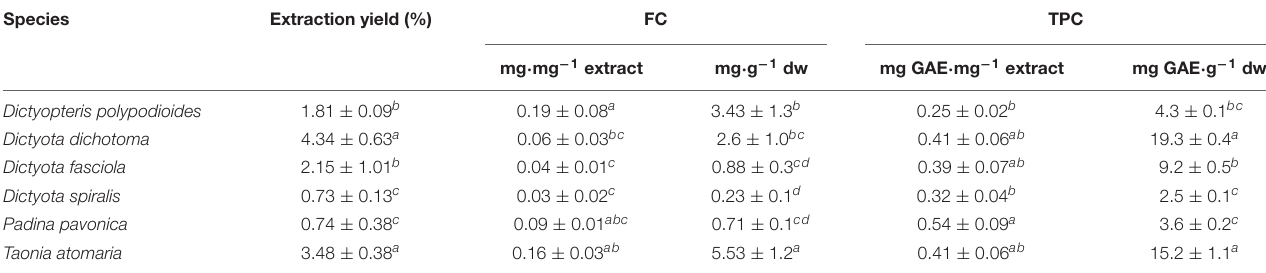
TABLE 1 | Extraction yield, fucoxanthin, and total phenolic content of Dictyotales samples. Species Extraction yield (%)